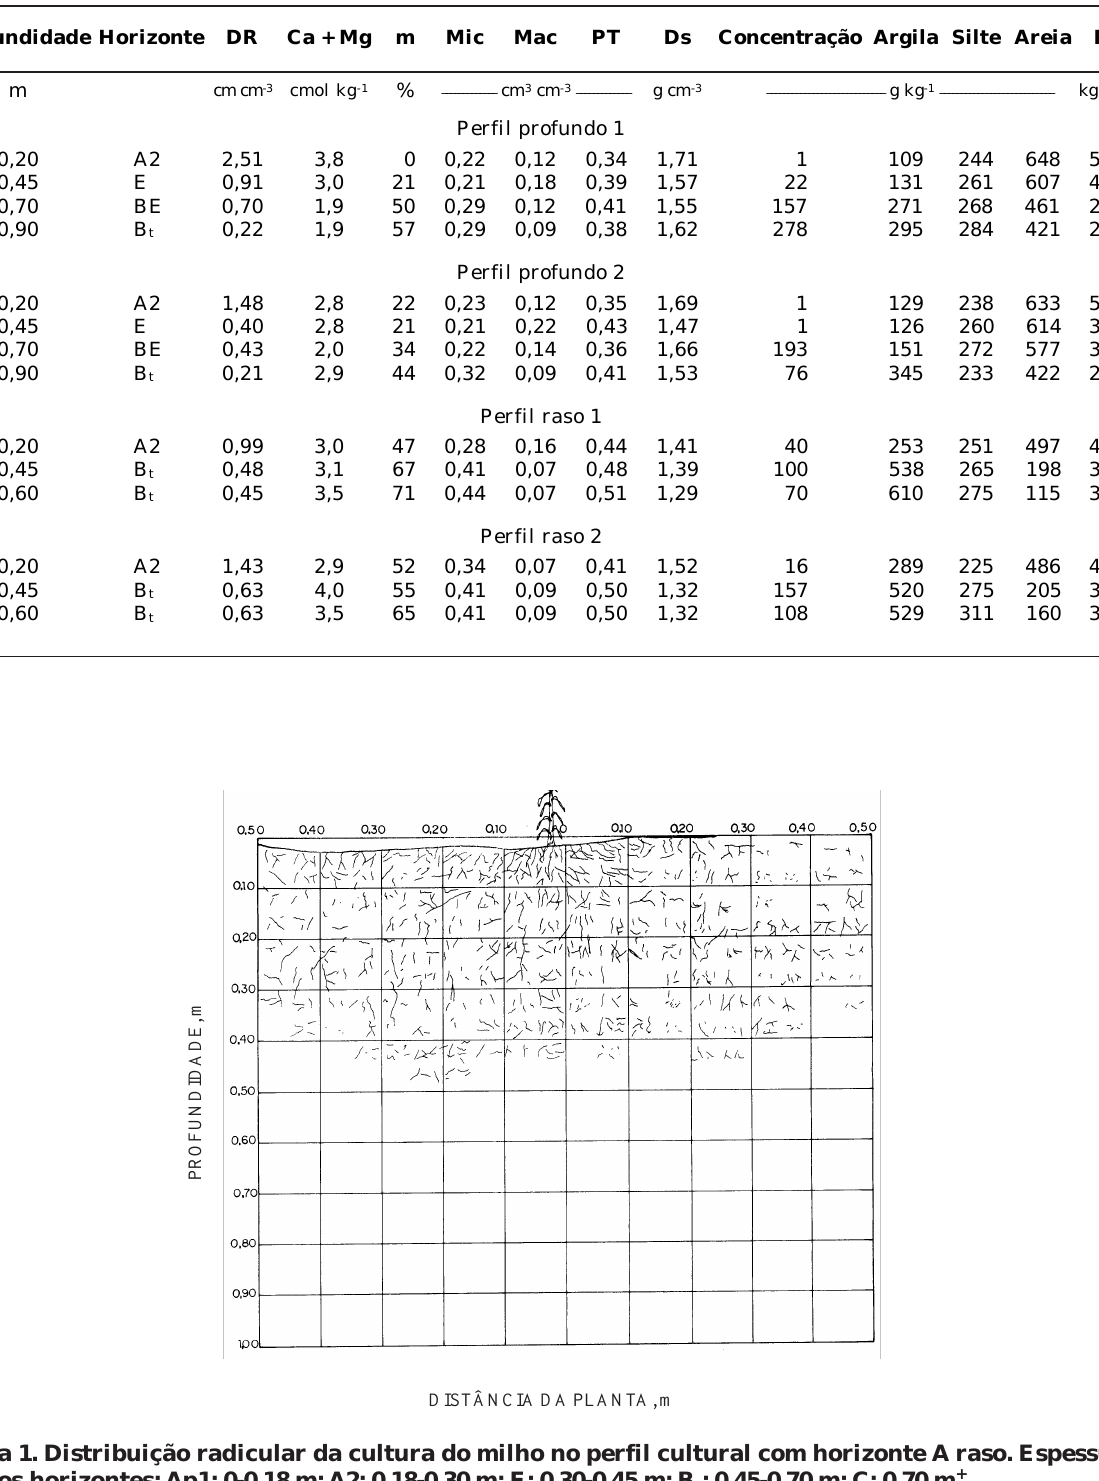
: 0,45-0,70 m; C: 0,70 m + t